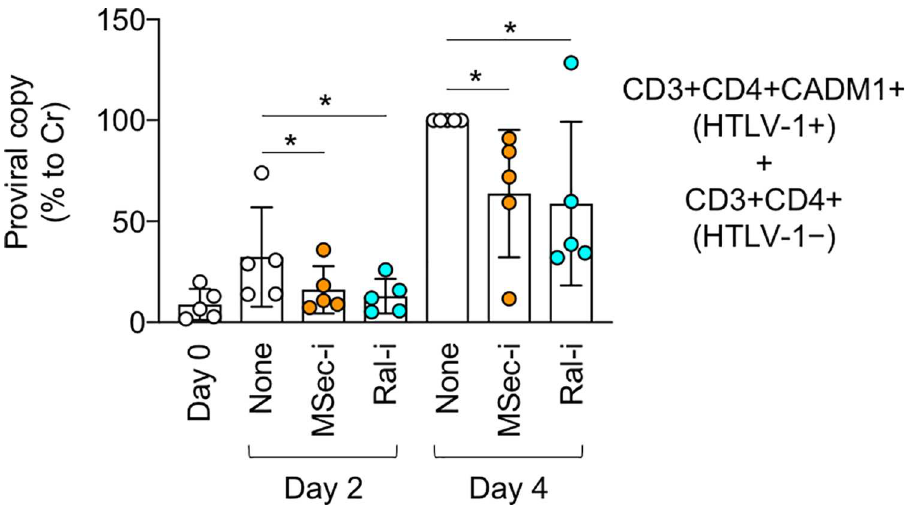
culture was quantified using qPCR and is shown as percentages relative to that of the co-culture with no inhibitor on day 4 (the third bar from the right). � p <